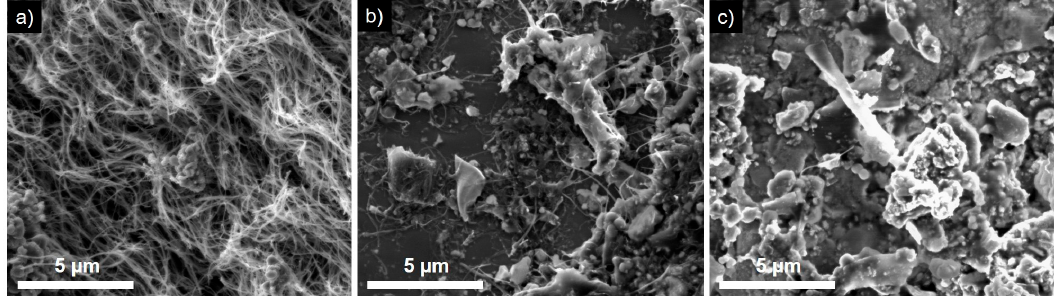
Figure 10. SEM images of DLICVD experiments conducted using an aspiration temperature of 225 °C, a reaction temperature of 1000 °C, a 1.25 wt.% catalyst concentration, using EtOH as a carbon source, and an injection rate of ( a ) 1 mL/h ( b ) 5 mL/h, and ( c ) 10 mL/h.